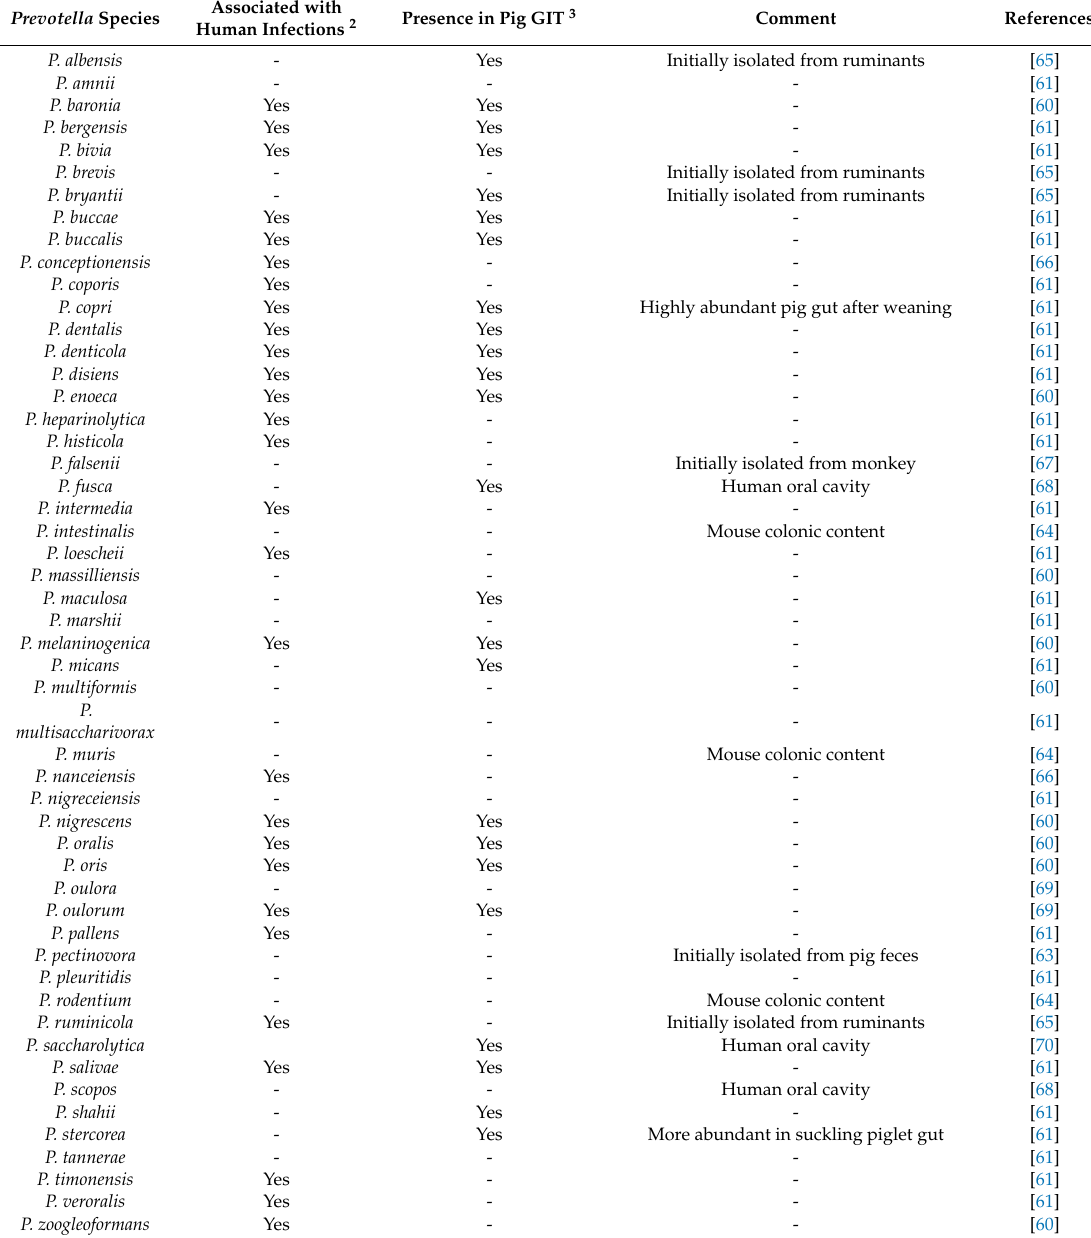
Table 1. Summary of the species in the genus Prevotella 1